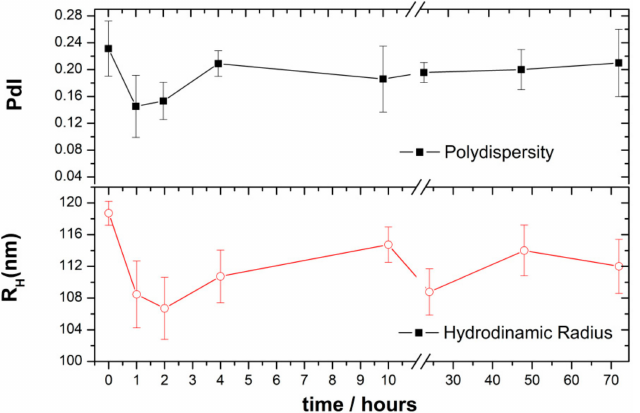
Figure 2. Enzymatic degradation of CHO / PA NPs in the presence of porcine lipase by DLS analysis. Data are expressed as mean ± s.e.m. from at least three independent experiments.